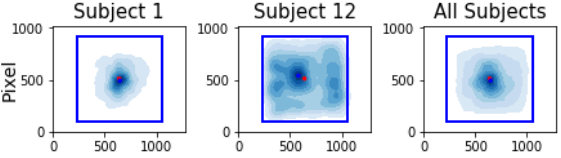
Figure 11. Fixation density maps for single subjects (left and center). Fixation density map over all subjects (right). Blue lines mark the size of the image on the screen in pixels (824x824). The axes lengths correspond to the overall screen size. The red dot marks the screen and stimulus center. The blue dot marks the point of the highest fixation